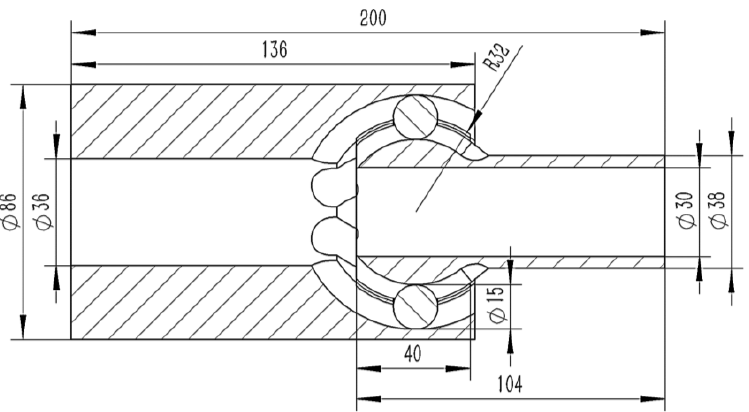
Figure 7. Geometric parameters of BCFJ (mm).